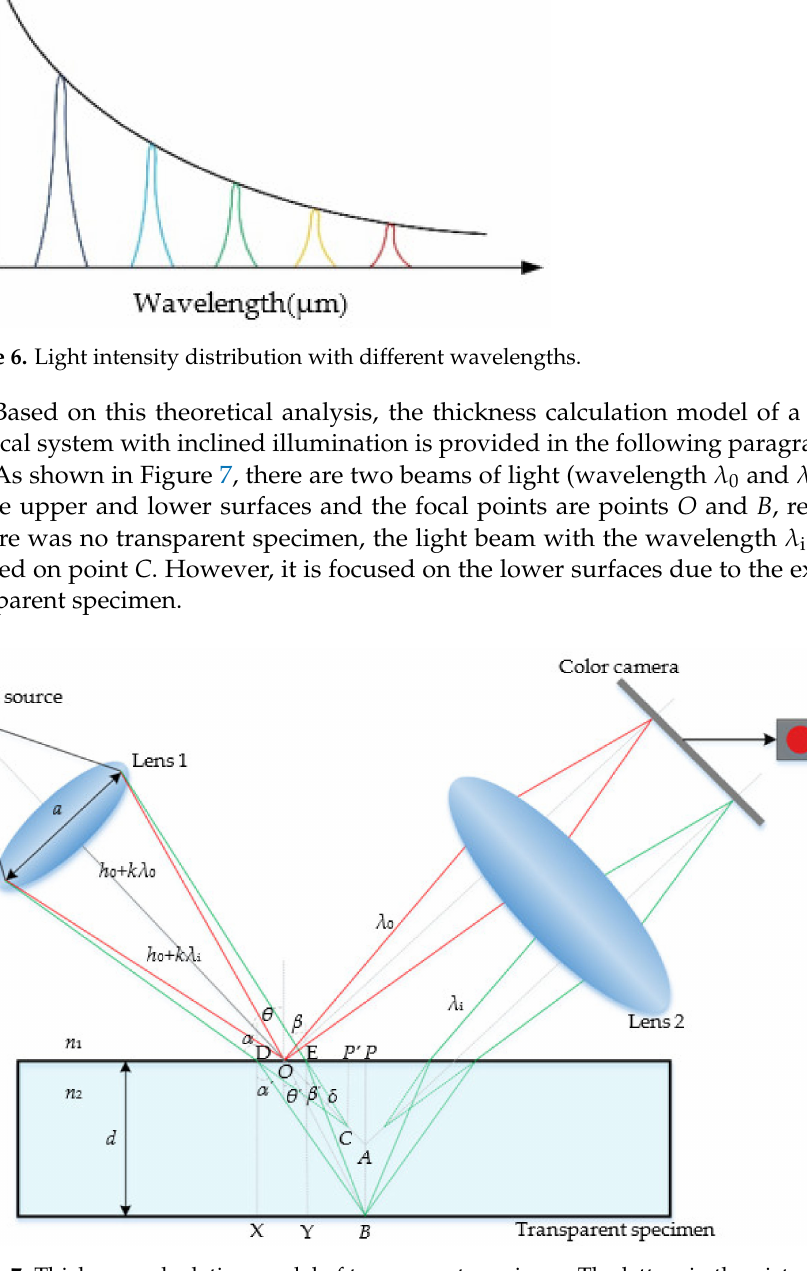
Figure 7. Thickness calculation model of transparent specimen. The letters in the picture represent the following meanings: n 1 the refractive index of the air; n 2 : the refractive index of the transparent specimen; a : the diameter of lens 1; d : the thickness of the transparent specimen; θ : the inclined angle of the system; h 0 + k λ 0 : the distance between point O and lens 1; h 0 + k λ i : the distance between point C and lens1; α : the index angle of the left light beam with the wavelength λ i ; β : the index of the right light beam with the wavelength λ i ; α (cid:48) : the refraction angle of the left light beam with the wavelength λ i ; β (cid:48) : the refraction angle of the right light beam with the wavelength λ i